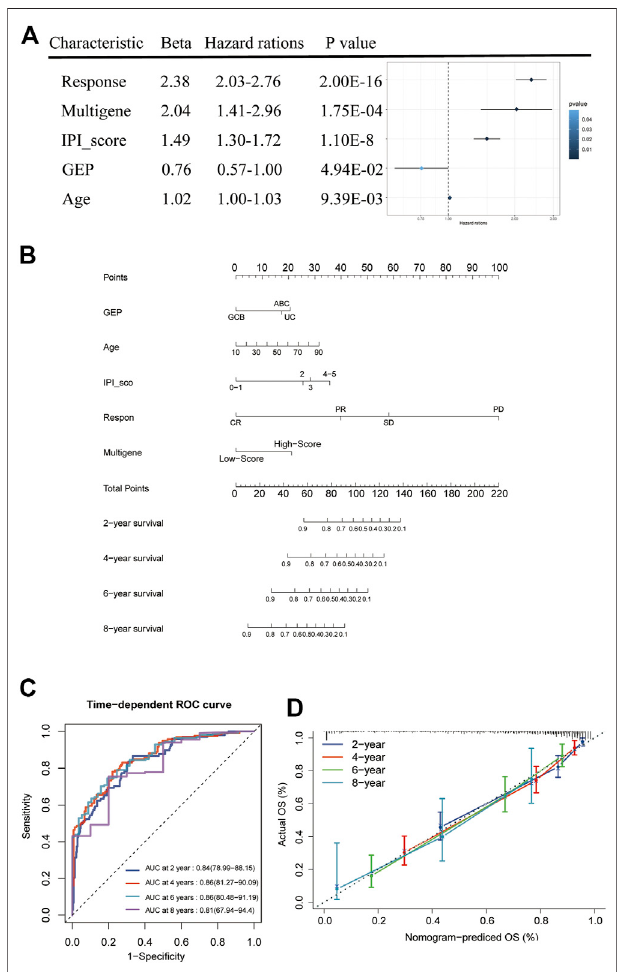
FIGURE 7 | Nomogram construction and prognostic value of the signature. (A) Forest plot of clinical factors and risk score. (B) The nomogram for predicting the survival rate after 2, 4, 6, and 8 years in DLBCL patients. (C) The time-dependent ROC analysis of nomogram predicting the survival rate after 2, 4, 6, and 8 years in DLBCL patients. (D) Calibration plots of the nomogram.